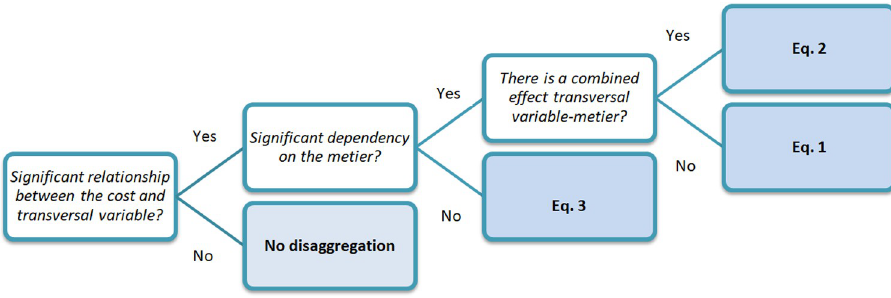
Fig 2. Decision support flow for the selection of the appropriate equation for the disaggregation of costs.